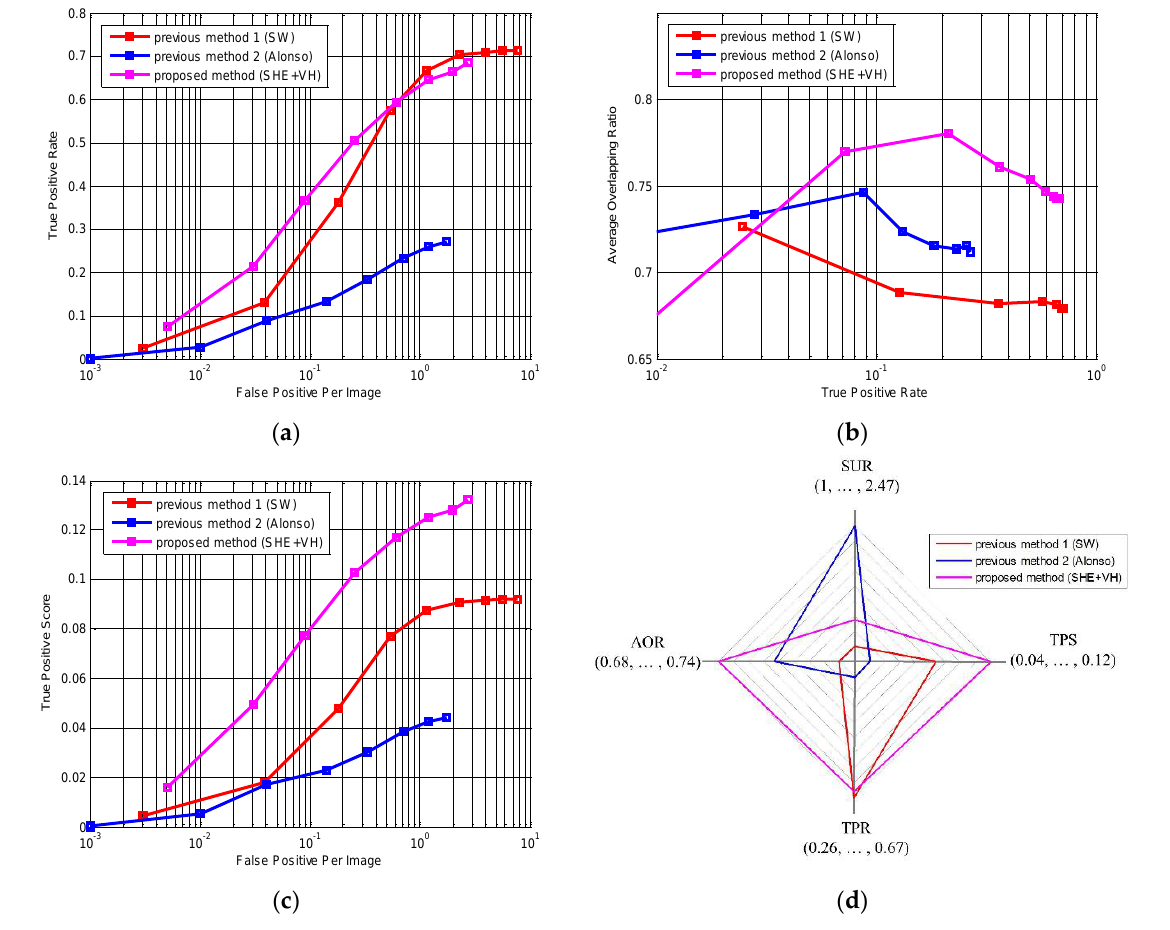
Figure 13. The detection performance in terms of ( a ) FPPI (false positive per image) vs . TPR (true positive rate); ( b ) TPR vs. AOR (average overlapping ratio); ( c ) FPPI vs. TPS (true positive score); and ( d ) SUR (speed-up ratio) vs . TPS vs. TPR vs . AOR when FPPI is 1. Table 3. The overall performance of the proposed and previous methods (when FPPI is 1). Methods TPS TPR AOR